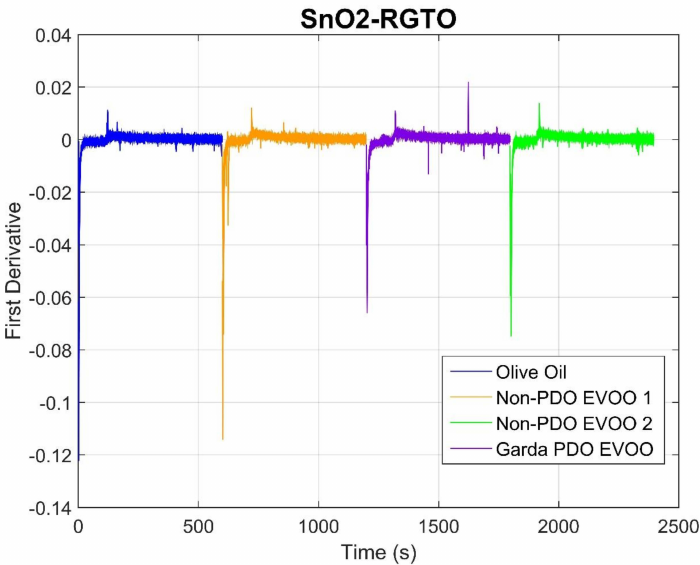
Figure 2. First derivative signals of a SnO 2 -RGTO sensor. On the x-axis is time (s), on the y-axis are first derivative